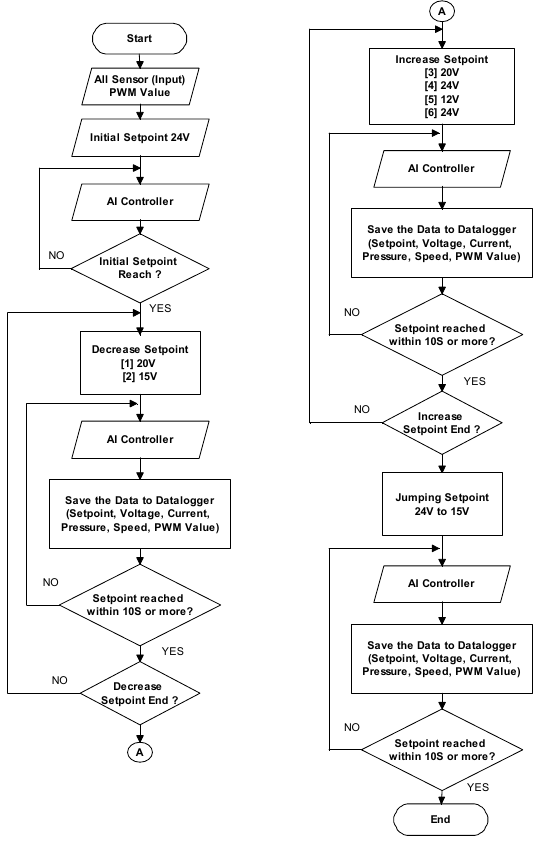
Figure 13. Flowchart Scenario 1.